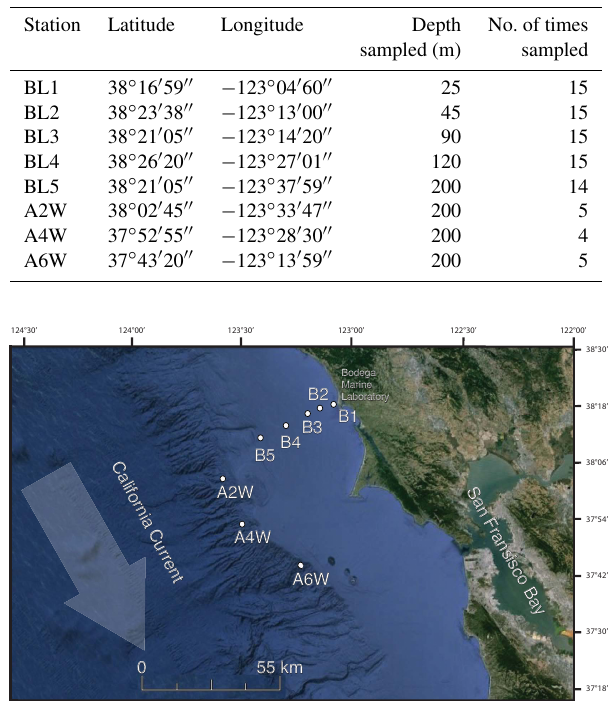
Figure 1. Map of tow stations BL1-5, A2W, A4W, and